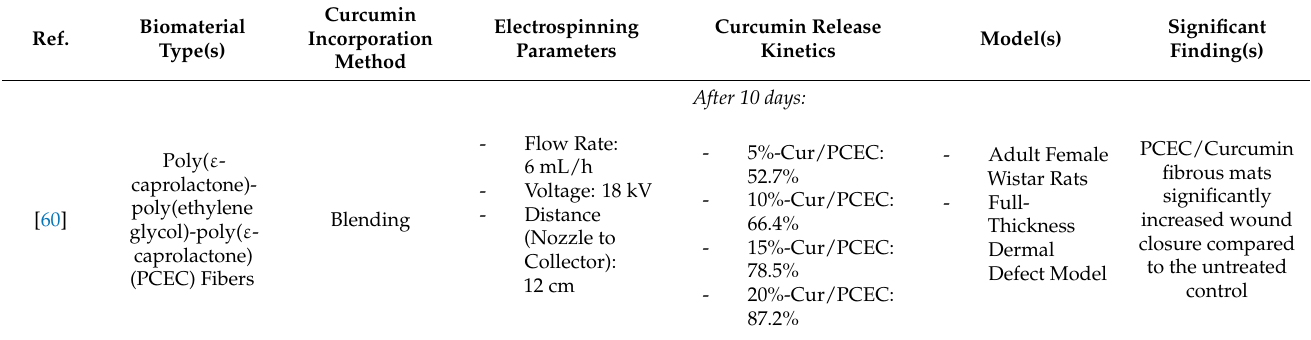
Table 2. Curcumin delivery from electrospun fiber